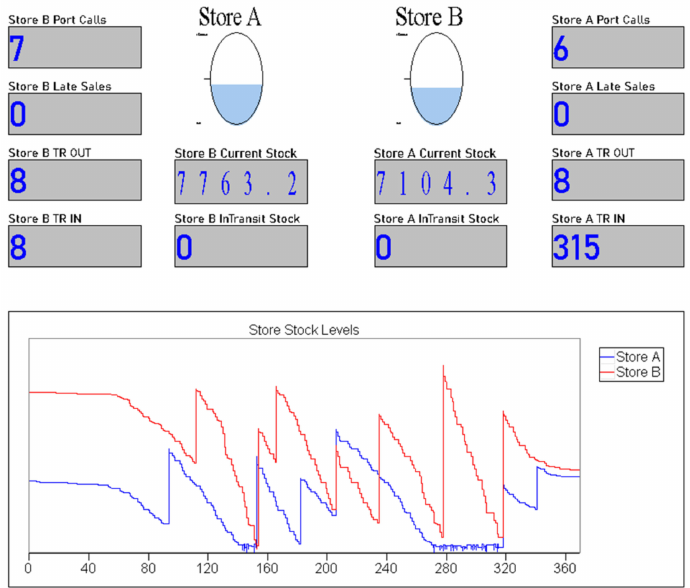
Figure 27. Snippet from the Arena ® dashboard with some of the modelling